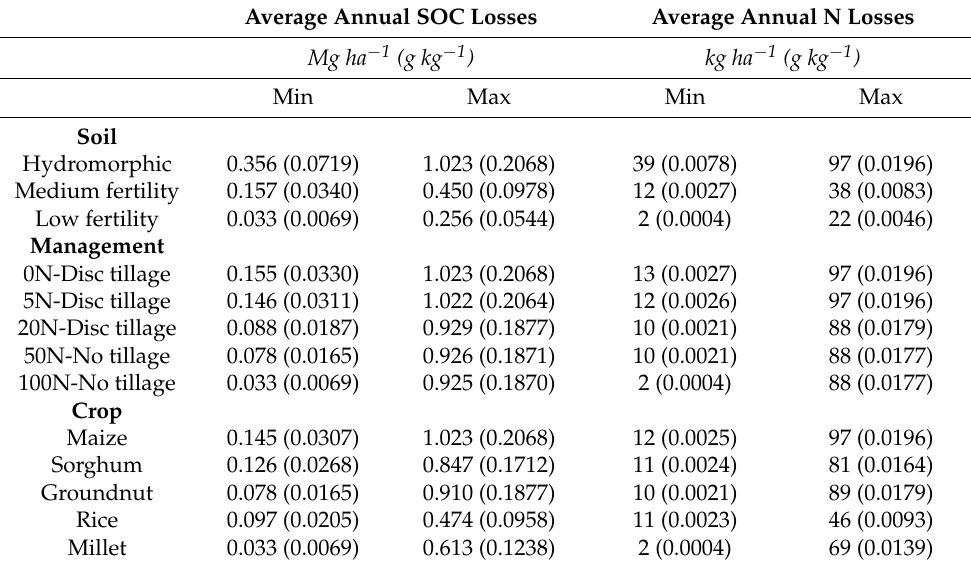
Table 2. Range of simulated nutrient losses for the different production